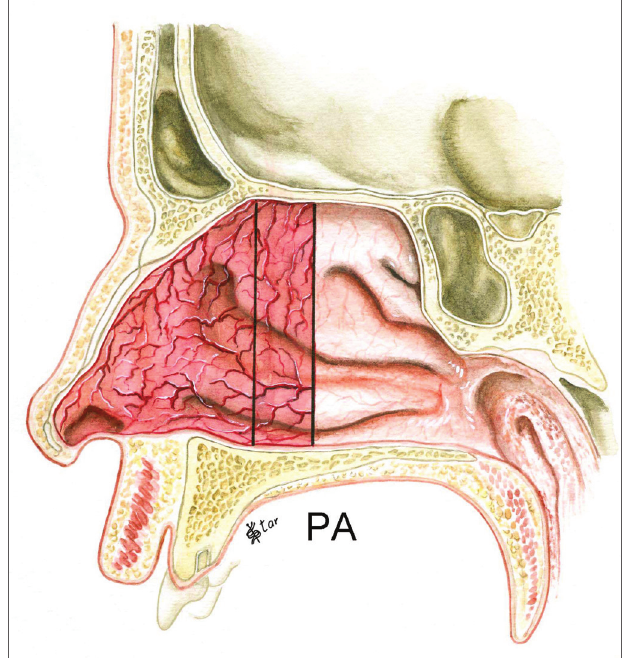
Figura 8. Estadiamento da PN no plano ântero-posterior - PA - pólipos com extensão anterior ao meato médio